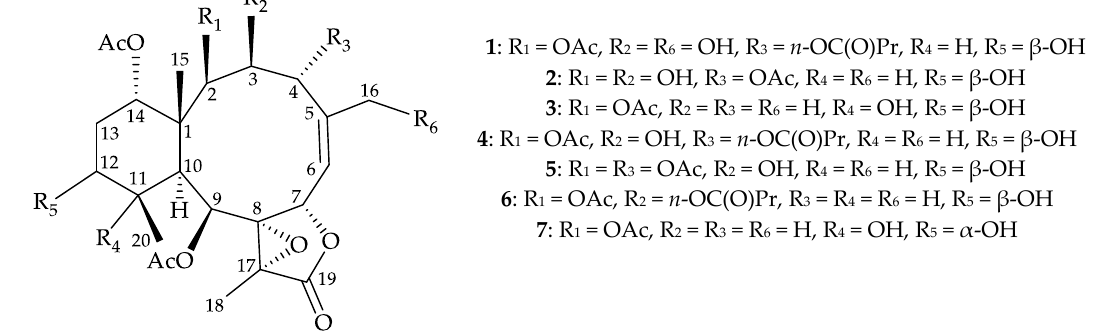
Table 1. 13 C NMR (δ C 100 MHz, CDCl 3 ) data for briaranes 1 – 3 . Position